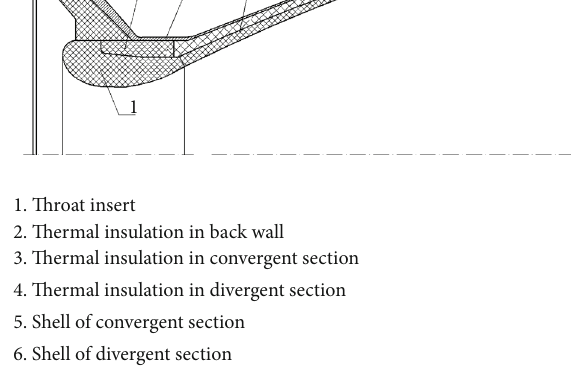
Figure 1: Two-dimensional axisymmetric model of the